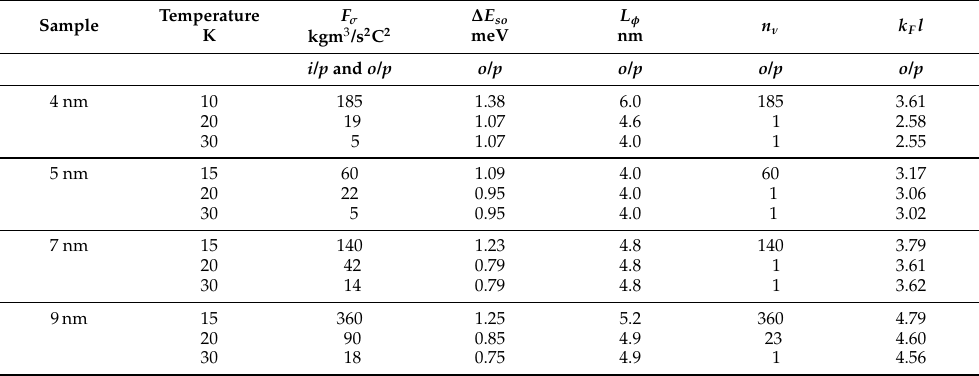
Table 1. Temperature-dependent modelling parameters. The Coulomb interaction constant ( F σ in kgm 3 /s 2 C 2 ) was extracted from in-plane ( i/p ) and MR was isotropic, i.e., F σ ( i/p ) = F σ ( o/p ). spin–orbit interaction energy ( ∆ E so in meV), dephasing length ( L φ in nm), and valley degeneracy factor ( n ν ) were extracted from out-of-plane ( o/p ) MR for samples 4 nm , 5 nm, 7 nm, and 9 nm. F Sample Temperature